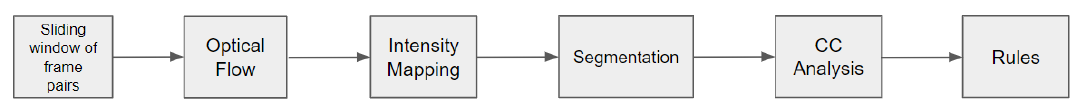
Figure 5. Alternative Python pipeline using rules for target association.